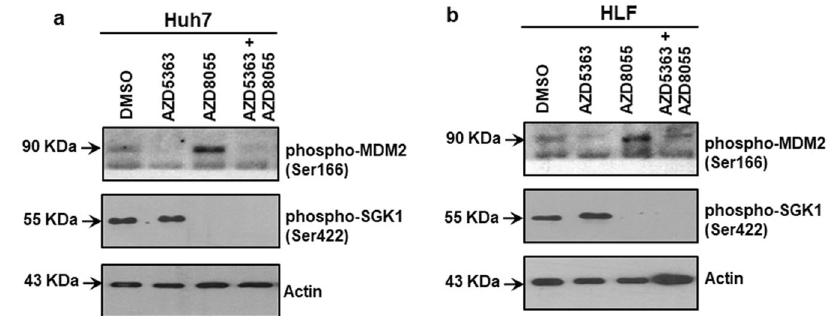
Fig. 5 Regulation of FOXO3a activation by inhibitor treatment. Western blot analysis was performed using p53 mutated HCC cell lysates after treatment with individual or a combination of 5 µM AZD5363 and 100 nM AZD8055 inhibitors for 48 h. The expression of phospho- MDM2 (Ser166) and phospho-SGK1 (Ser422) in Huh7 ( a ) and HLF ( b ) cell lysates are shown. Expression level of actin in each lane was considered for comparison of protein load and illustrated by representative blots shown at the